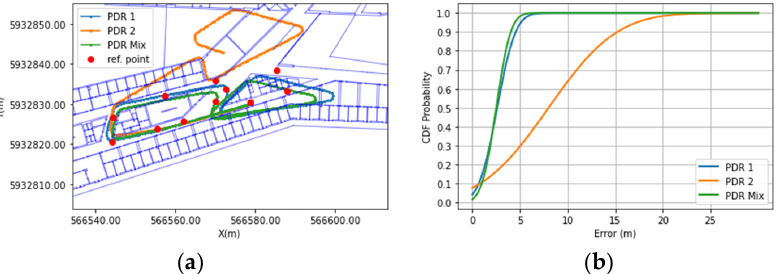
Figure 3. Three different PDR realizations, named PDR 1 (the k-based stride length and Madgwick-based heading), PDR 2 (fixed stride length and leveled gyroscope heading), and PDR mix (the k-based stride length and leveled gyroscope heading): ( a ) Trajectories shown on the map; and ( b ) Error vs. CDF probability of the methods.